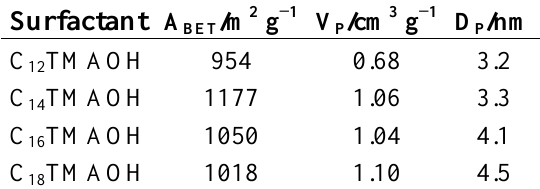
Table 3. Specific surface area A sorption for the transformation products obtained using alkyltrimethylammonium-based surfactants with alkyl chain lengths of C12, C14, C16 and C18.